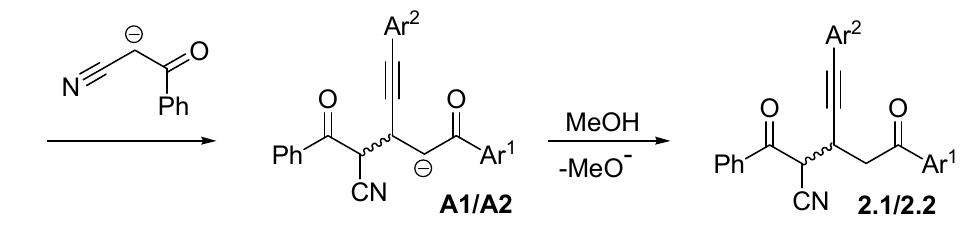
Scheme 2. Plausible mechanism of the reaction of enynones 1 with 3-oxo-3-phenylpropanenitrile